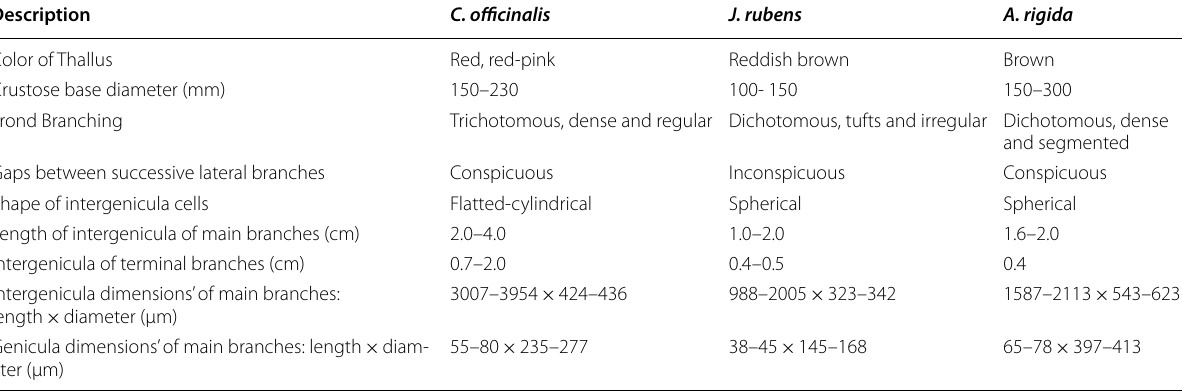
Table 2 Morphological assessment of the studied species in the Eastern Harbor during 2019–2020